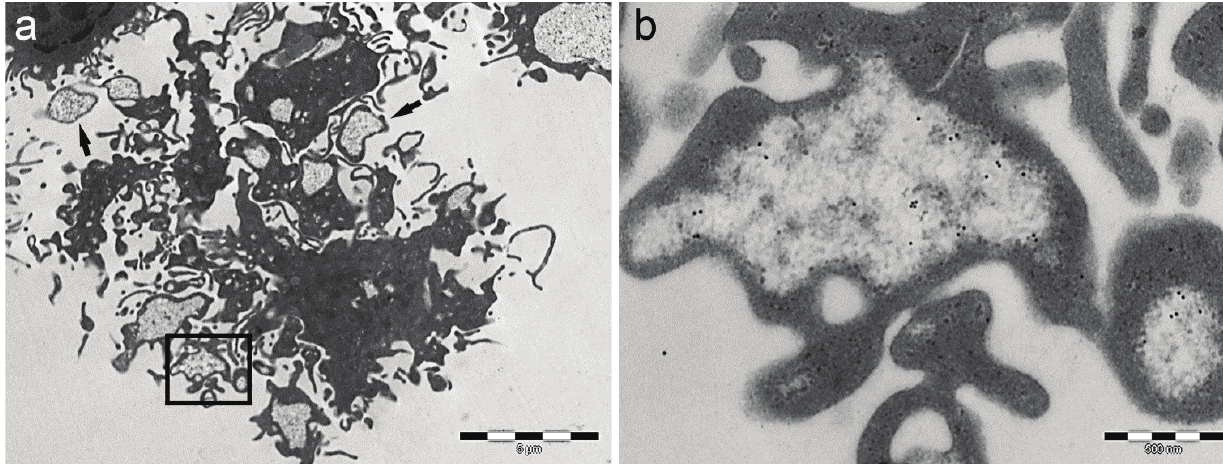
Figure 4. Extracellular fate of PaCS. ( a , b ) LPS-treated dendritic cells obtained in vitro with five days of GM-CSF and IL-4 treatment of blood mononuclear precursors show PaCS-filled blebs, some of which are detached from the cell and float in the surrounding space as free, cytoplasmic membrane enveloped vesicles (ectosomes; the black arrows